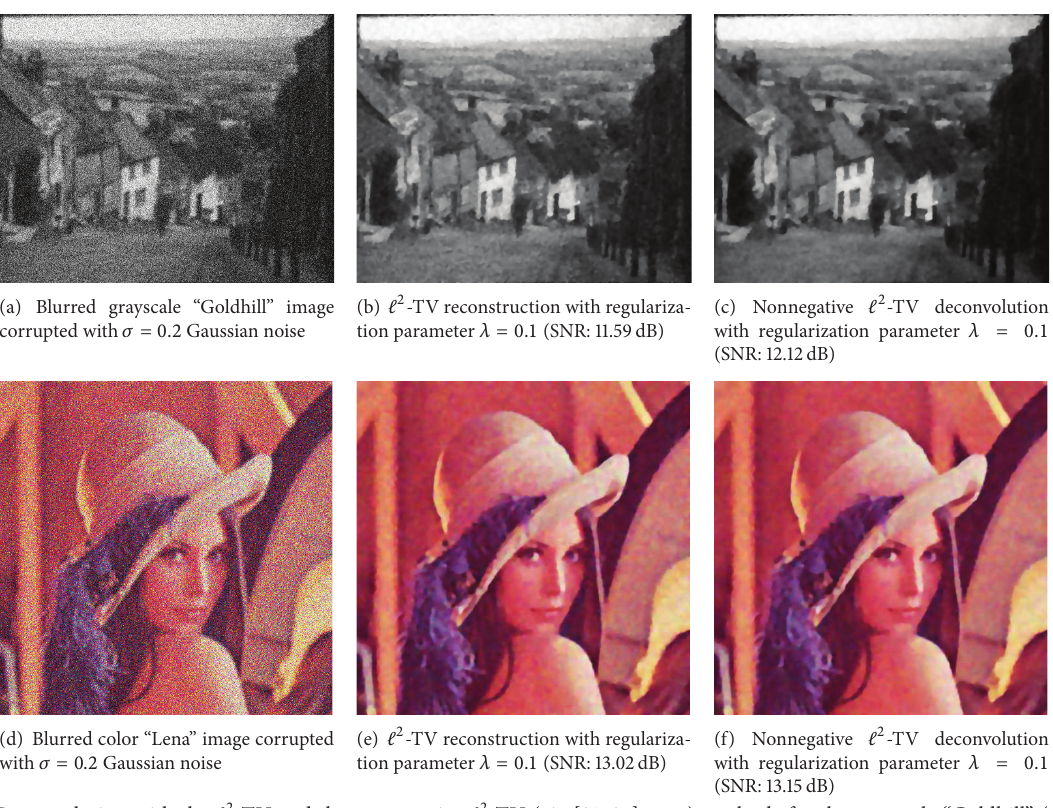
Figure 1: Deconvolution with the ℓ 2 -TV and the nonnegative ℓ 2 -TV (via [81, 87] resp.) methods for the grayscale “Goldhill” ( 720 × 576 ) image and the color “Lena” ( 512 × 512 ) image.